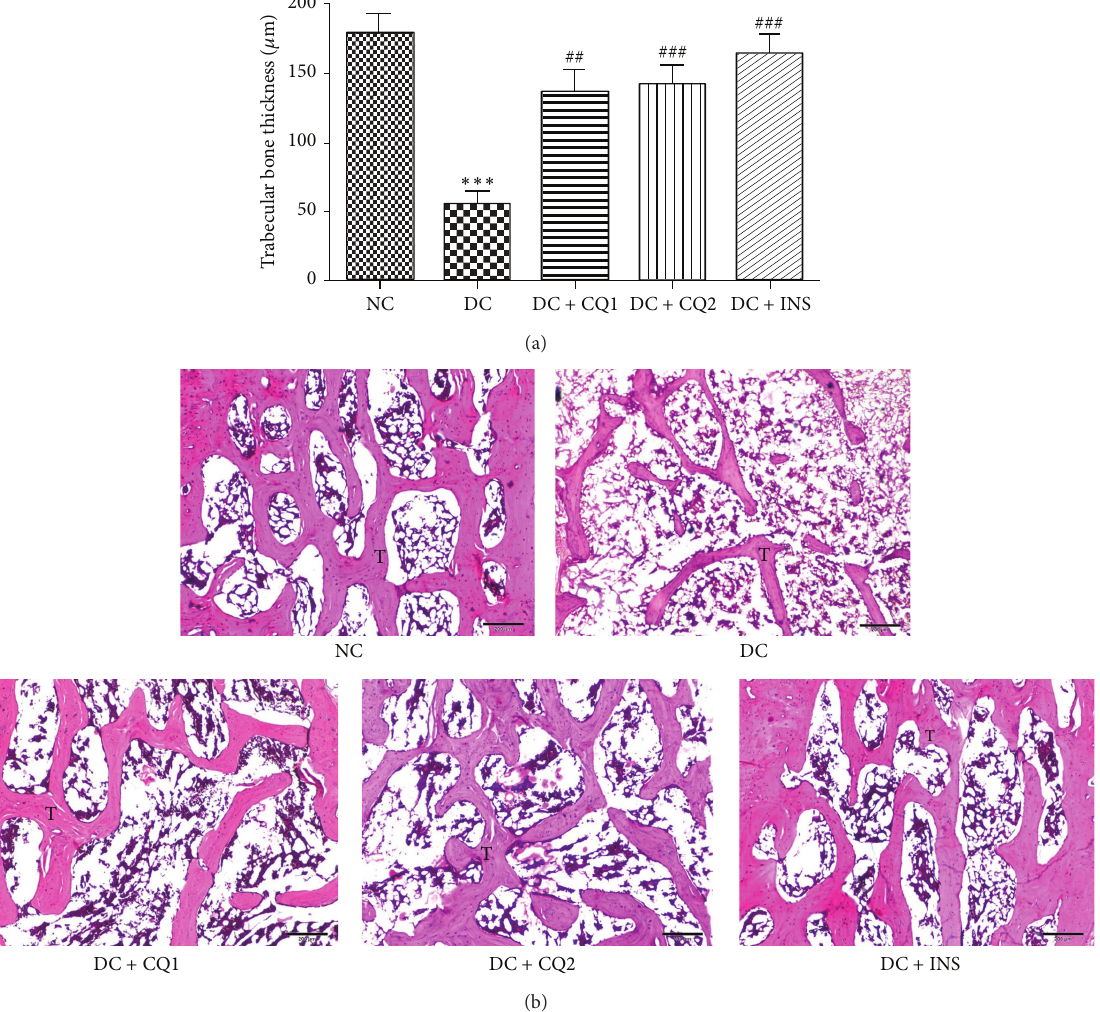
Figure 1: (a) Effect of PECQ on mean thickness of trabecular bone in the epiphyseal region. Significant decrease in the thickness of the trabecular bone was observed in the diabetic control (DC) rats when compared to normal control (NC) rats. However, diabetic rats treated with two different doses of PECQ (DC + CQ1 & DC + CQ2) or with insulin (DC + INS) showed a significant increase in bone thickness. ∗∗∗ 𝑃 < 0.001 when compared to NC group; ### 𝑃 < 0.001 , ## 𝑃 < 0.01 when compared to DC group. (b) Photomicrographs of trabecular bone in epiphyseal region. Thinner and reduced number of trabeculae can be seen in the diabetic control group (DC) when compared to normal control group (NC). Further treatment with two doses of PECQ (DC + CQ1, DC + CQ2) and insulin (DC + INS) improved the trabecular bone thickness. T: trabecular bone; H and E staining, scale bar: 200 𝜇